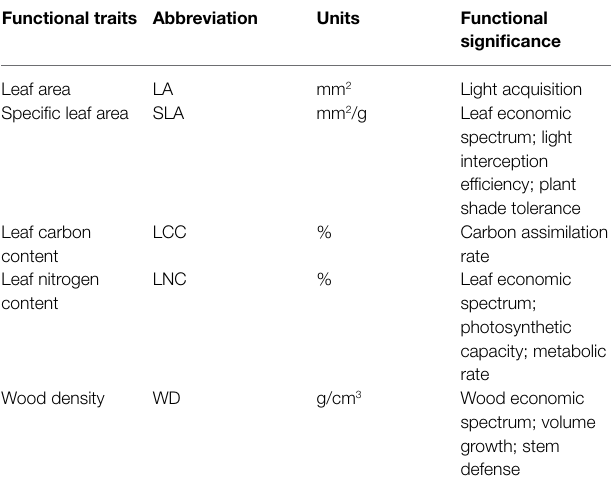
TABLE 1 | Significance of functional traits used in this study. Functional traits Abbreviation Units Functional